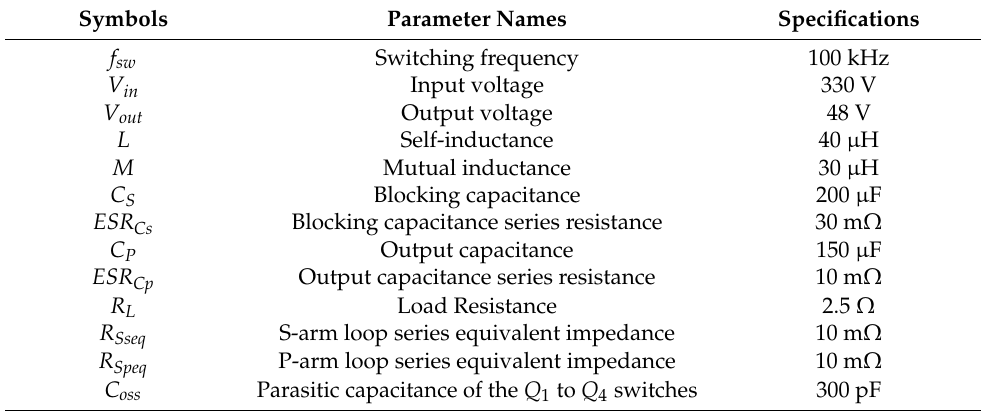
Figure 13. Simulation result of the transient response of the stacked buck converter with the boundary limit control method. Table 1. Circuit parameters.